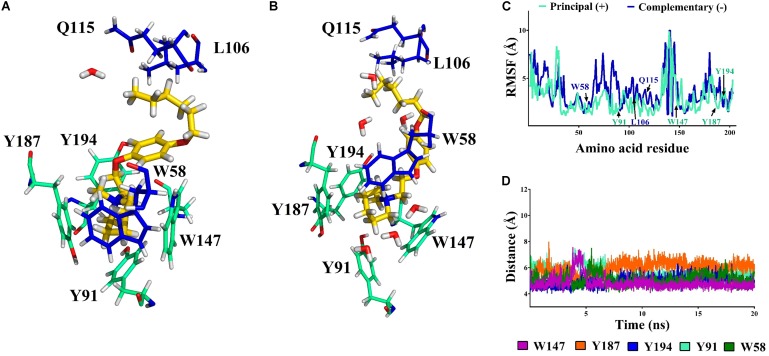
Compound 12a (in yellow) in the binding cavity of the α7 nAChR. (A,B) Shows the α7/12a complex at 0 and 20 ns, respectively. All amino acids from the principal (+)-and complementary (-)- chains a within 5 Å are displayed (cyan and blue, respectively). (C) The root mean square fluctuation (RMSF) values of the residues in the principal (+)- and complementary (-)-chains show the stability of the poses of the amino acids involved at the binding site during simulation. (D) The distance vs. time from nitrogen atom (NC) of 12a to the center of the aromatic amino acids (aromatic box) is shown.